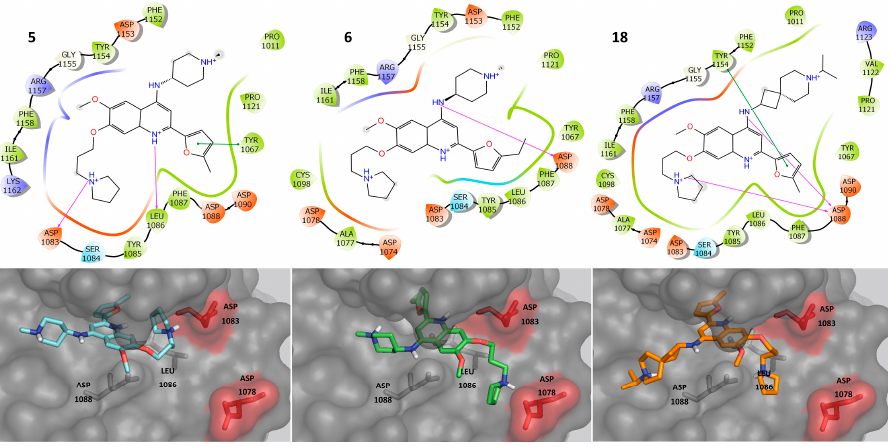
Figure 7. Predicted binding poses of selective compounds against G9a. Key amino acids proposed for the selective activity are highlighted in red.